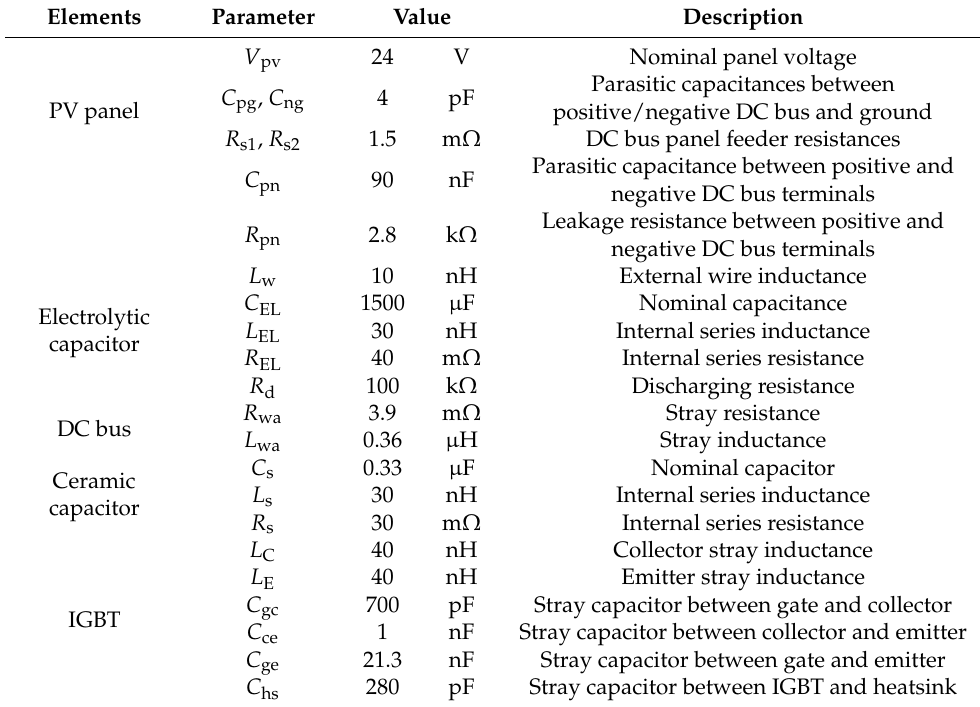
Table A1. Circuit model parameters of PV panel and inverter in Figure 3a.